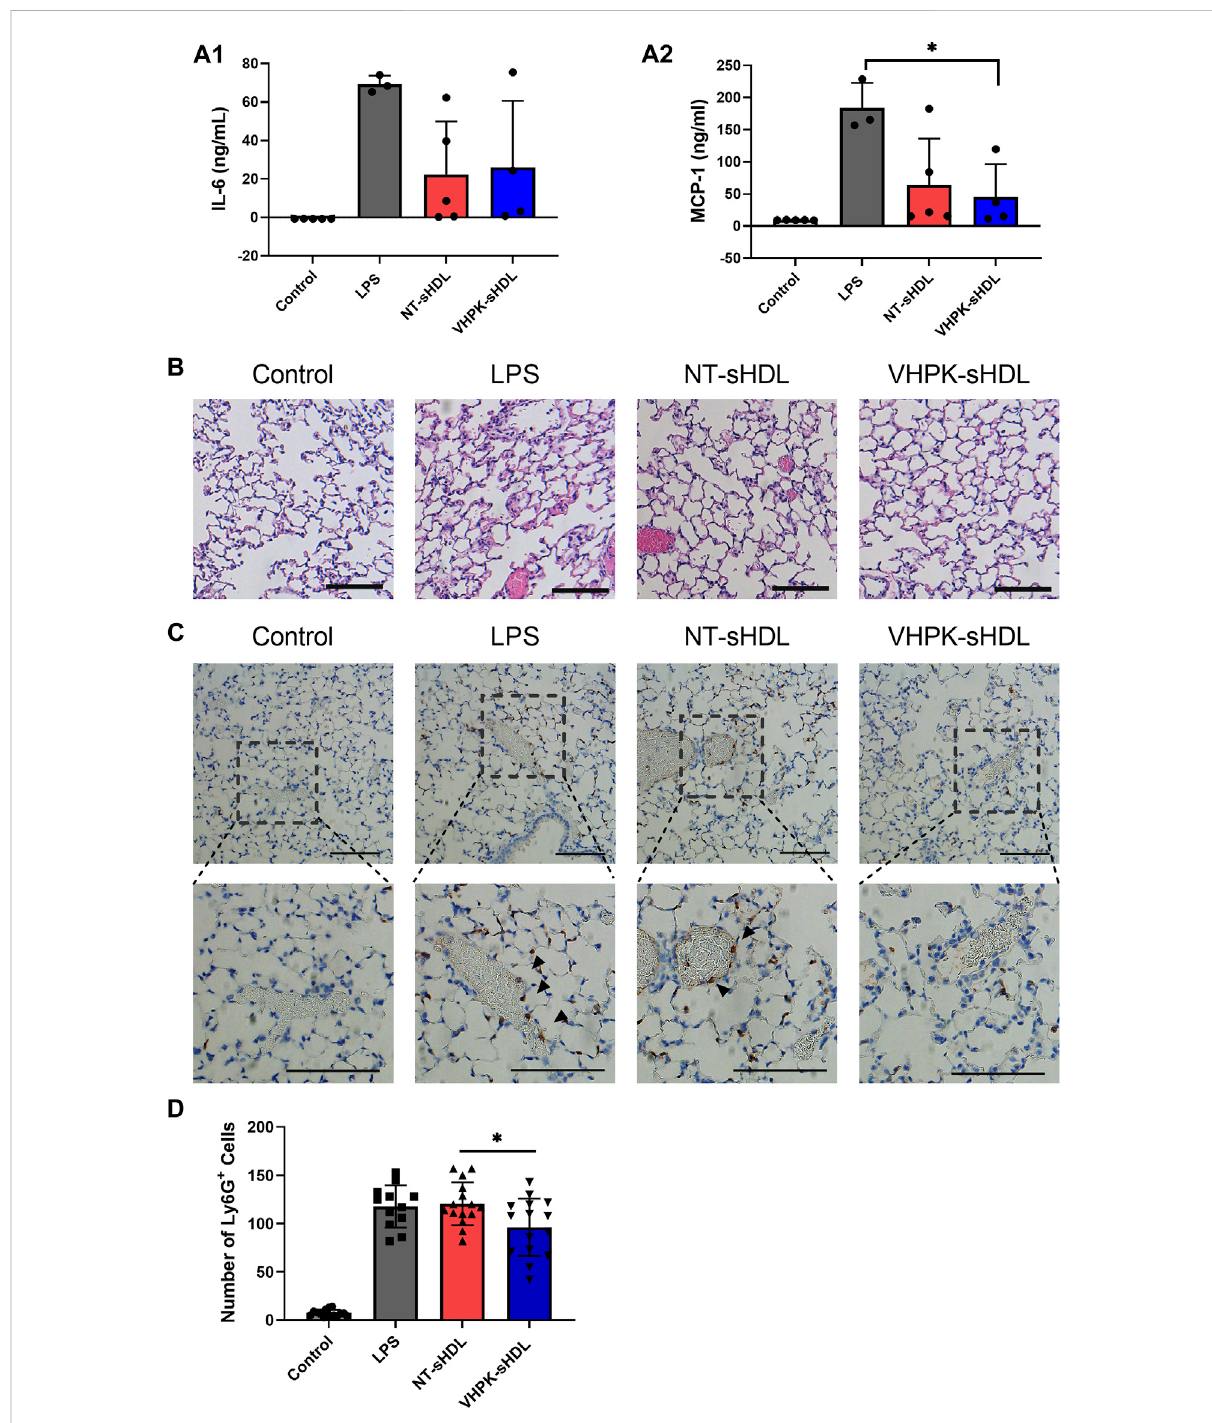
FIGURE 9 Plasma IL-6 (A1) and MCP-1 (A2) levels in mice 18 h after administration of LPS and sHDLs. (n = three to fi ve, mean ± SD, p < 0.05). (B) Representative H&E staining of lung tissue sections of mice treated with different sHDLs. (C) Representative images of Ly6G IHC staining of lung sections mice treated with different sHDLs. Control indicates mice without LPS or sHDL treatment. Arrows indicate endothelial bound Ly6G + cells. Thescale barrepresents100 μ m. (D) NumbersofLy6G + cellscounted fromIHC stainedlung tissue sections ( n = 12-15, mean±SD.Ly6G + cells were counted from three random 20x fi elds from slides of each